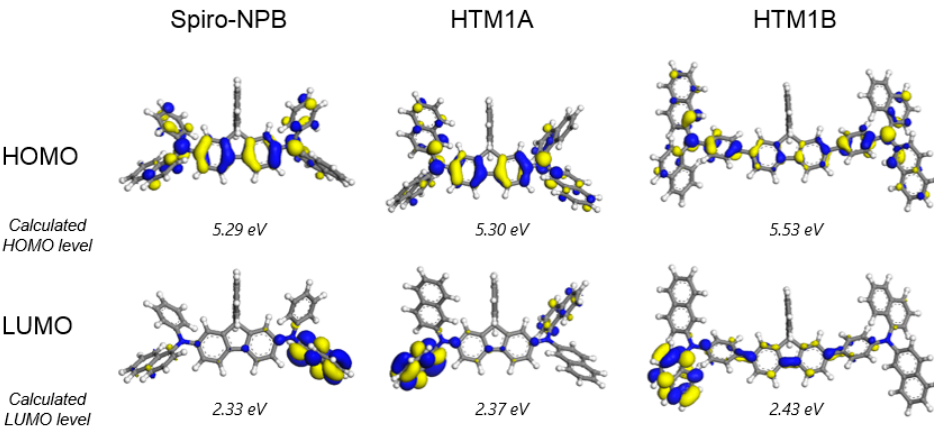
Figure 3. Calculated DFT frontier molecular orbitals of Spiro-NPB, HTM 1A and HTM 1B .